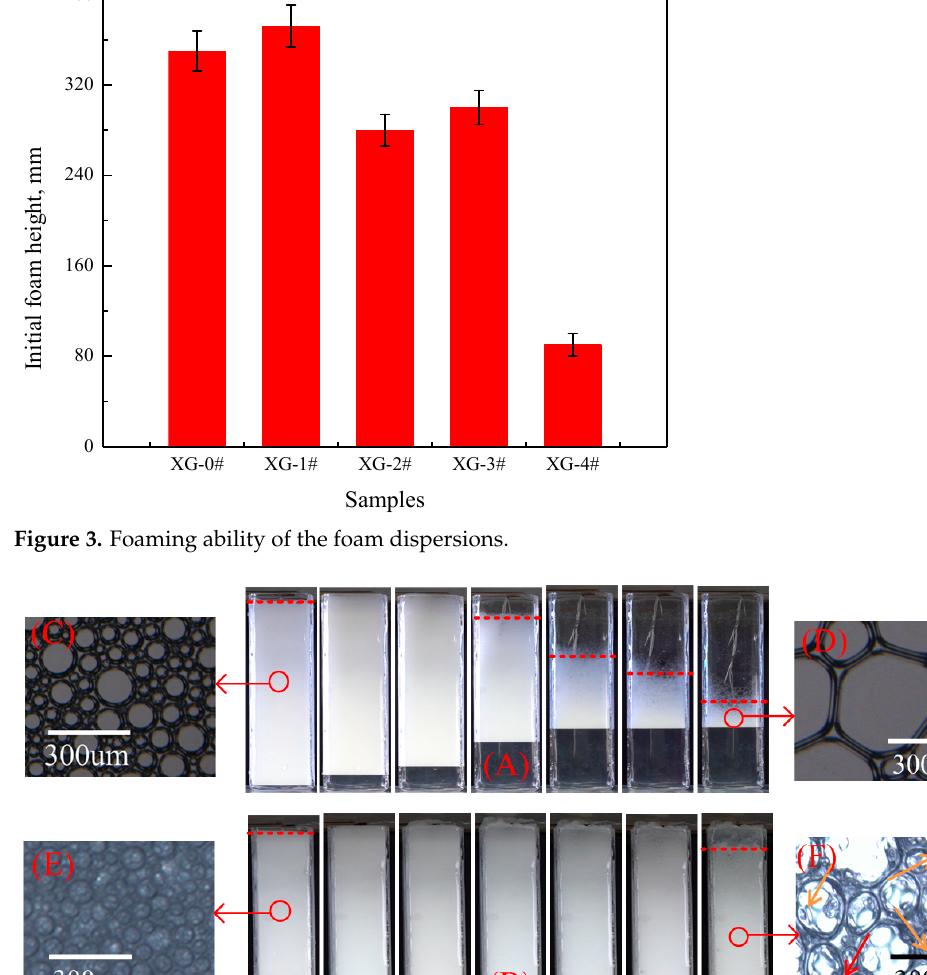
Figure 3. Foaming ability of the foam dispersions.